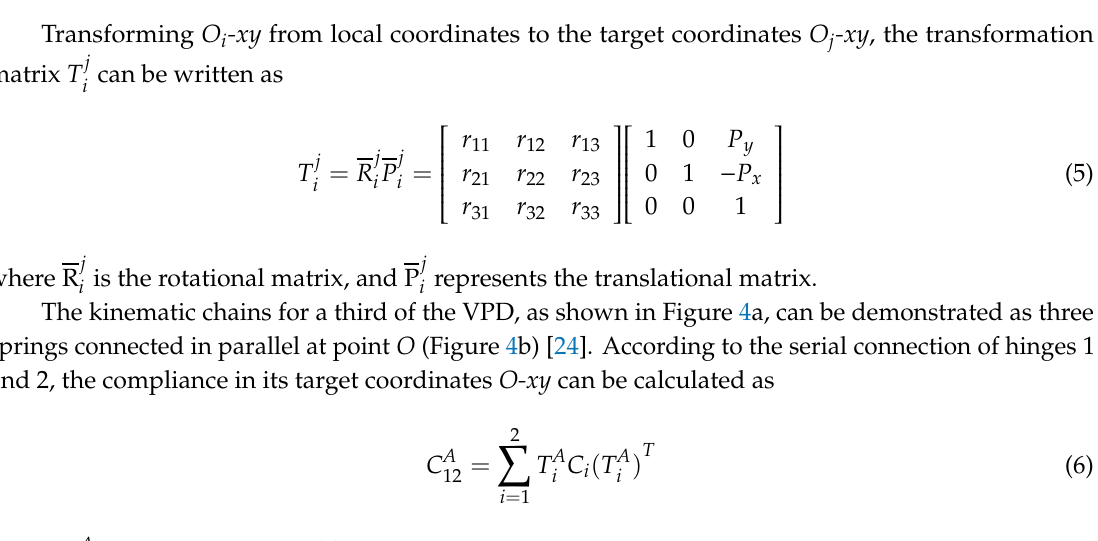
Figure 3. Coordinate system of the ( a ) right-angle hinge and ( b ) right-circular hinge.